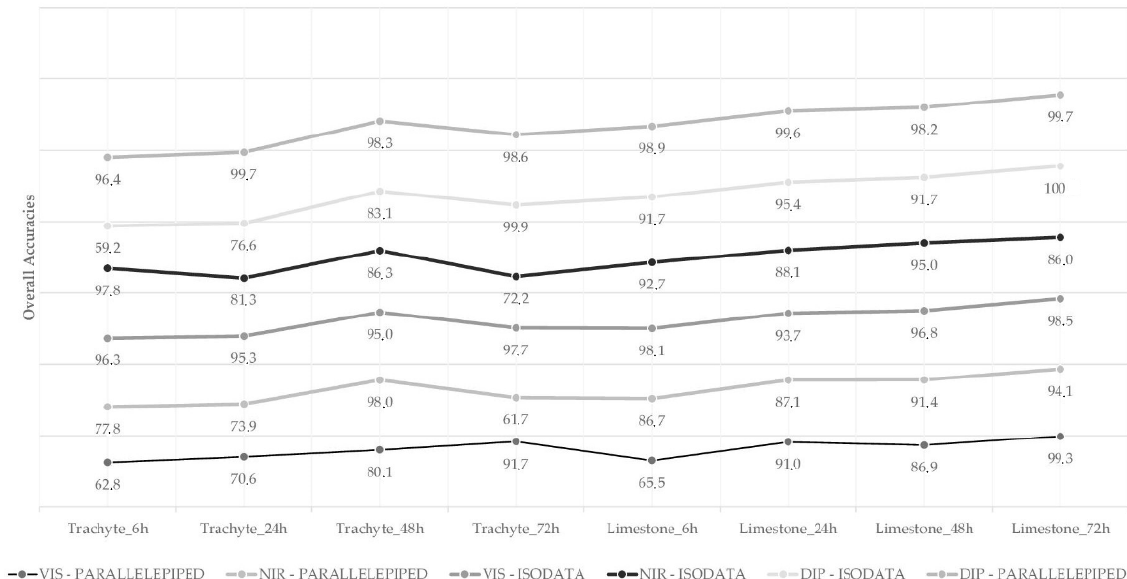
Figure 11. Averaged overall accuracy for each mixture and technique during the rolling-bottle test.